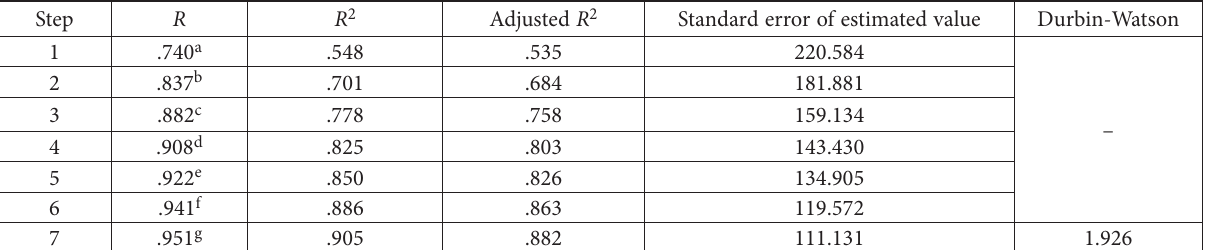
Table 10. Multiple linear regression analysis using the stepwise selection method – model